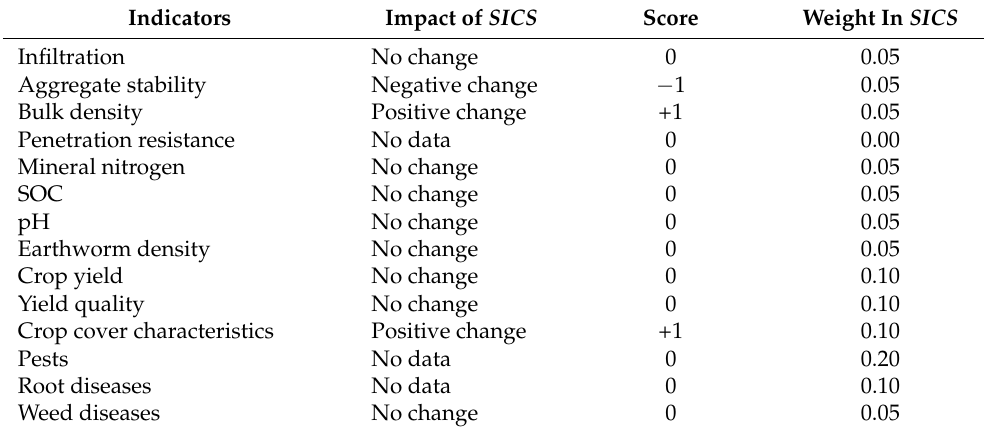
Table 3. Impact of cover crops on the variables at least two years after the implementation.